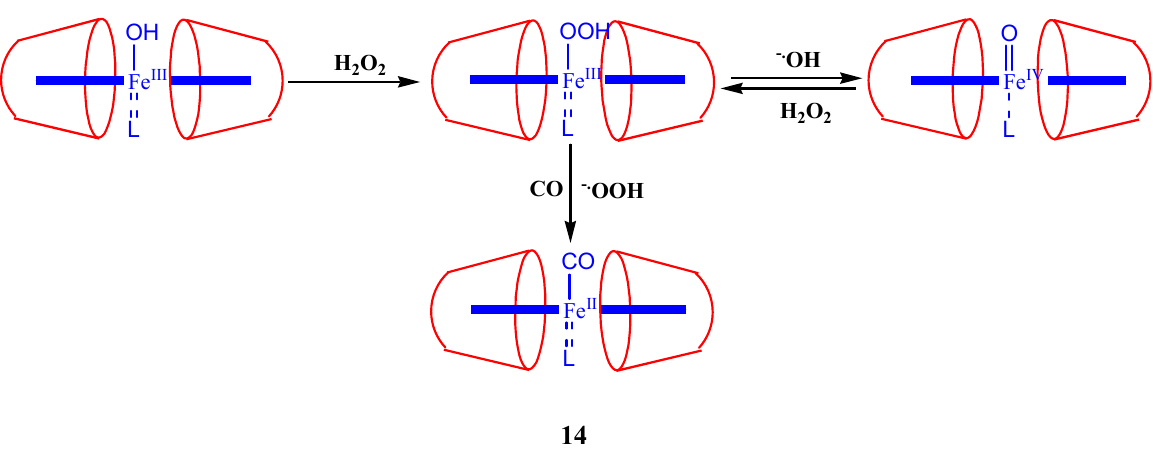
Figure 15. Schematic representation of iron-oxo intermediate formation after the uptake of H O by a pyridine-coordinated ferric porphyrin encapsulated in the cyclodextrin 2 2